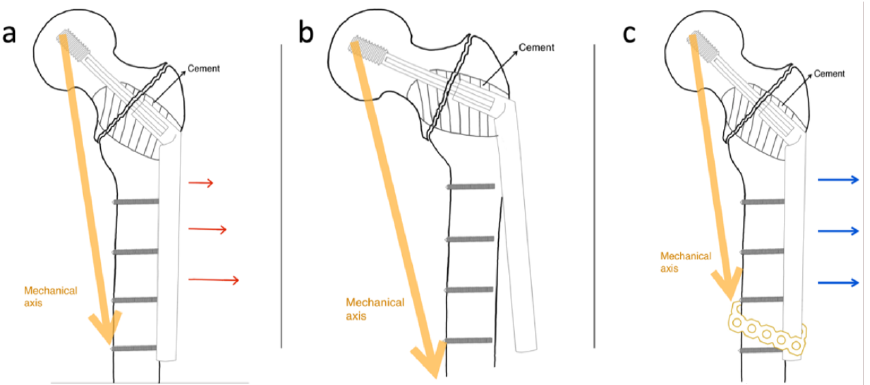
Figure 6. Illustration of the change in shearing force: ( a ) the shearing force increased due to PMMA cement augmentation, ( b ) loading failure with distal cortical screw fracture with SHS fixation only, and ( c ) the modified SHS technique increases the strength to resist the shearing